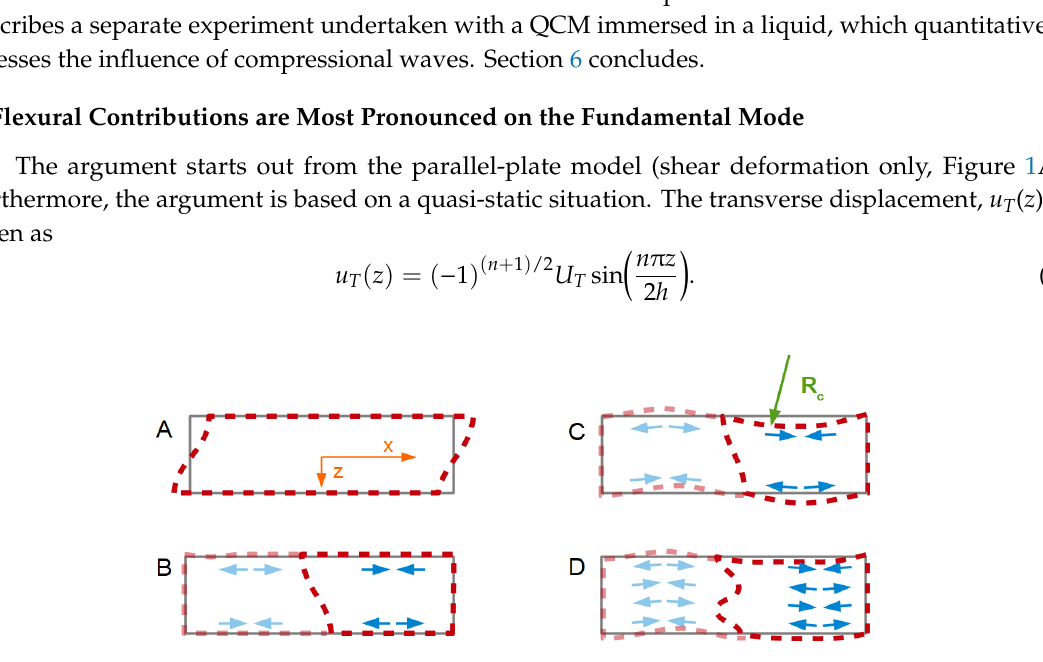
Figure 1. In the idealized parallel plate model, the amplitude of the shear wave is the same, everywhere ( A ). If the amplitude of shear varies across the surface ( B ), a compressive stress and a tensile stress result at the two surfaces of the plate. These will bend the plate ( C ). Bending will also occur on the overtones, but to a lesser extent ( D ).